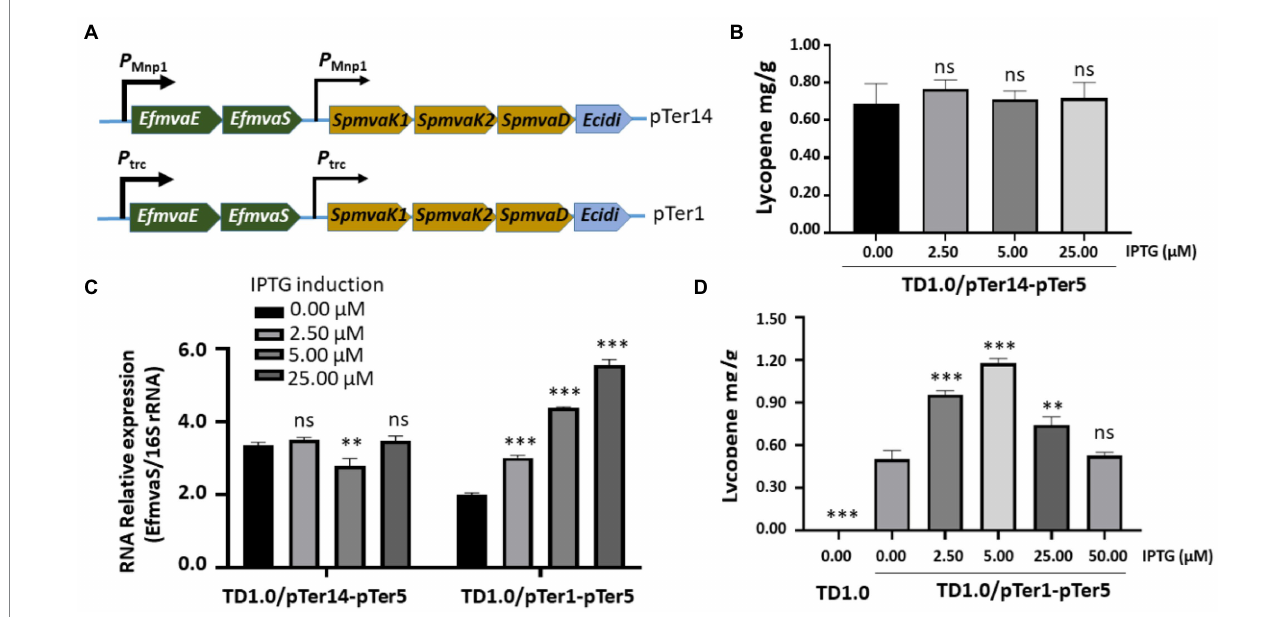
FIGURE 4 Optimizing promoters for enhanced lycopene synthesis. (A) Schematic diagram of the construction of the pTer14 and pTer1 plasmids carrying genes involved in the MVA pathway. The promoters that regulate the expression of MVA pathway genes were indicated. HPLC analysis of lycopene production from TD1.0/pTer14-pTer5 (B) and TD1.0/pTer1-pTer5 (D) after induction with different concentrations of IPTG. TD1.0 without IPTG induction served as negative control. The experiments were repeated three times for each concentration of IPTG induction. Cells were grown in a minimal medium supplemented with 30 g/L glucose as carbon source. All samples were obtained after 48 h cultivation at 37 ° C with shaking. The lycopene yield was analyzed by HPLC, calculated using the standard curve, and presented as mg per gram of dried cell weight (DCW). (C) RT-qPCR detection of EfmvaS expression in TD1.0/pTer14-pTer5 and TD1.0/pTer1-pTer5 cells with or without IPTG induction. The transcript level of the target gene was normalized to that of the 16S rRNA gene. The experiment was repeated at least three times. The data were presented as mean ± SD. Statistical significance was calculated by One-way ANOVA and compared to the engineered bacteria that did not receive IPTG induction; ns indicates no statistical significance, ** p < 0.01, and *** p <